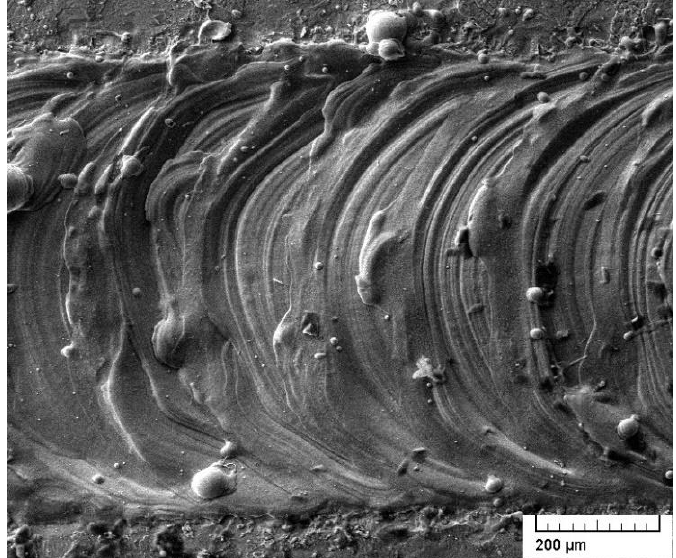
Figure 2. Top view of the welded joint.